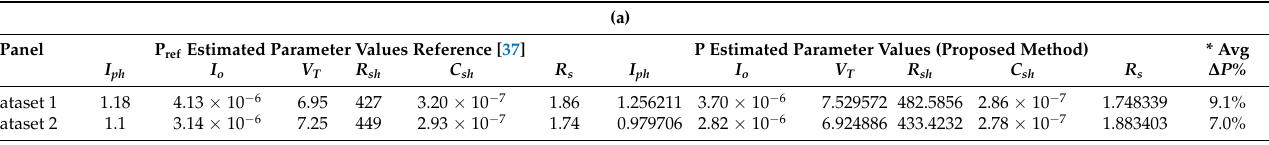
( b ) (Blue-measured results, Green-results by proposed method)